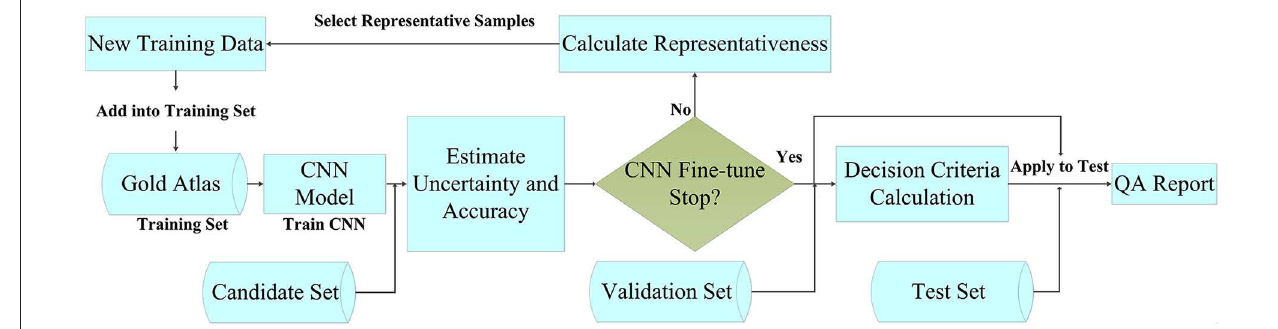
FIGURE 1 | Flowchart of the contouring quality assurance